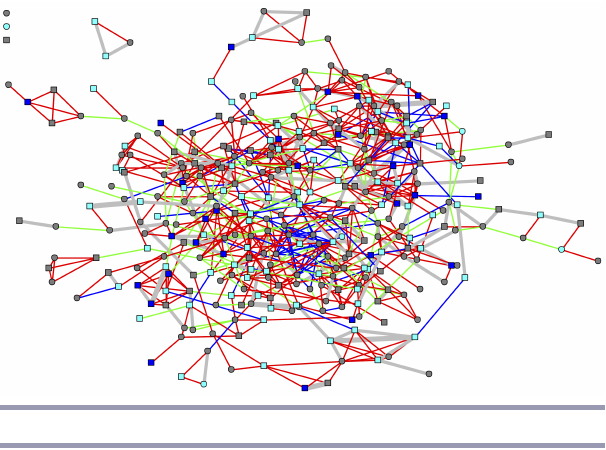
Fig. 2 . The community strong-tie network. Individuals are represented according to a code of shapes and colors: men (square), women (circle), commercial fishers (dark blue), consumption fishers (light blue), and rest of the population (gray). Friendship, occupation, kinship, and multiple relations are, respectively, shown in green, blue, red, and gray. Links involving two and three types of relations are, respectively, twice and three times as large as the links involving only one.